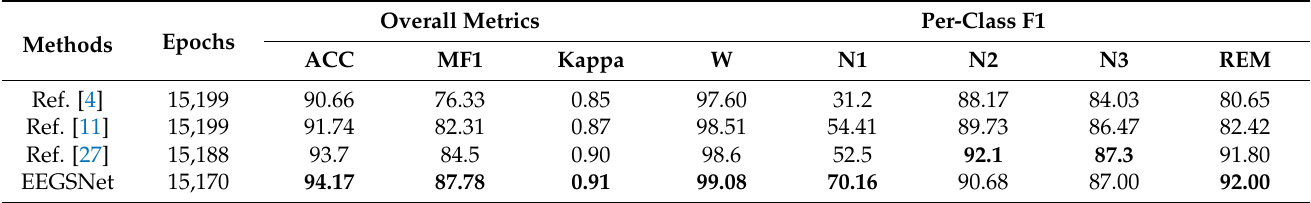
Table 7. Comparison of performance metrics obtained by our method with other state-of-the-art algorithms on Sleep-EDFX-8.